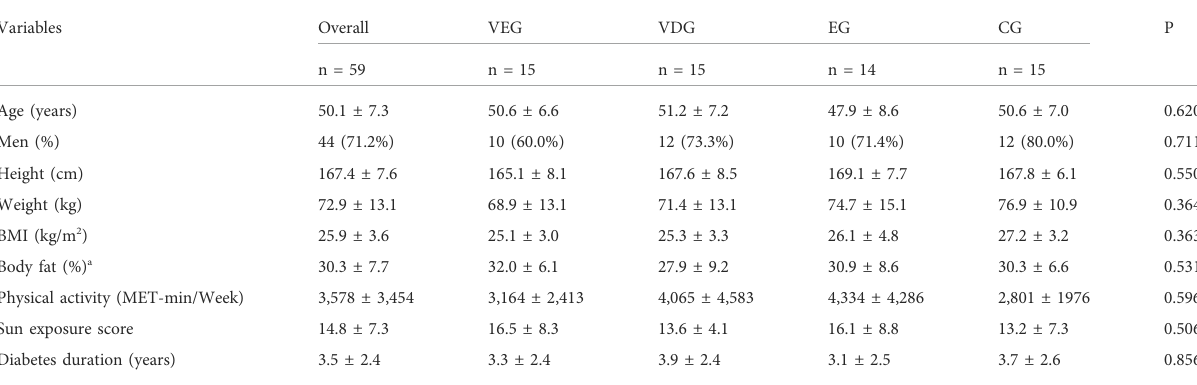
TABLE 1 Subject characteristics at baseline in 59 patients with type 2 diabetes mellitus at baseline.